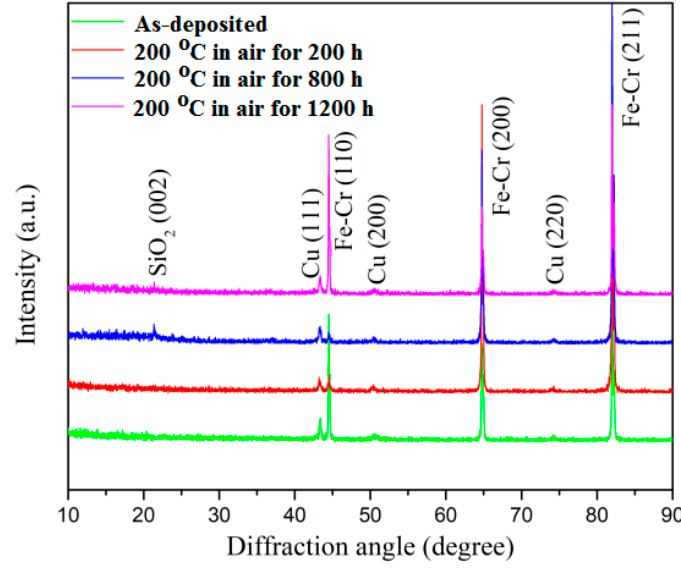
Figure 7. XRD spectra of the SSC as-deposited and after heat